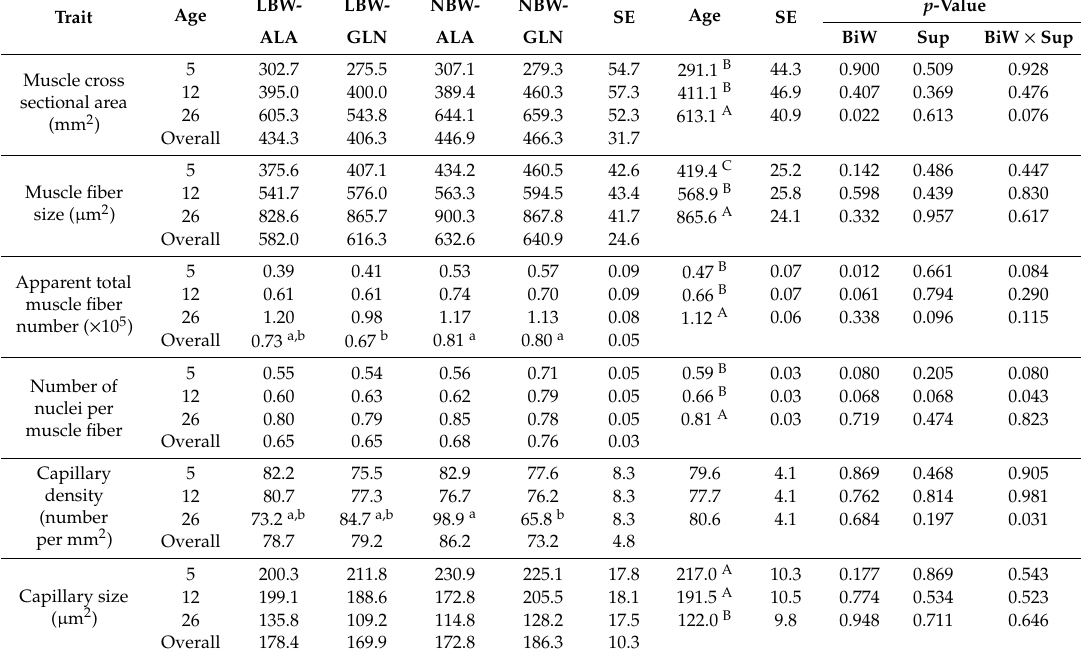
Table 3. Morphological traits in M. semitendinosus of low (LBW) and normal birth weight (NBW) piglets supplemented with glutamine (GLN) or alanine (ALA) between 1 and 12 dpn ( n = 12 per